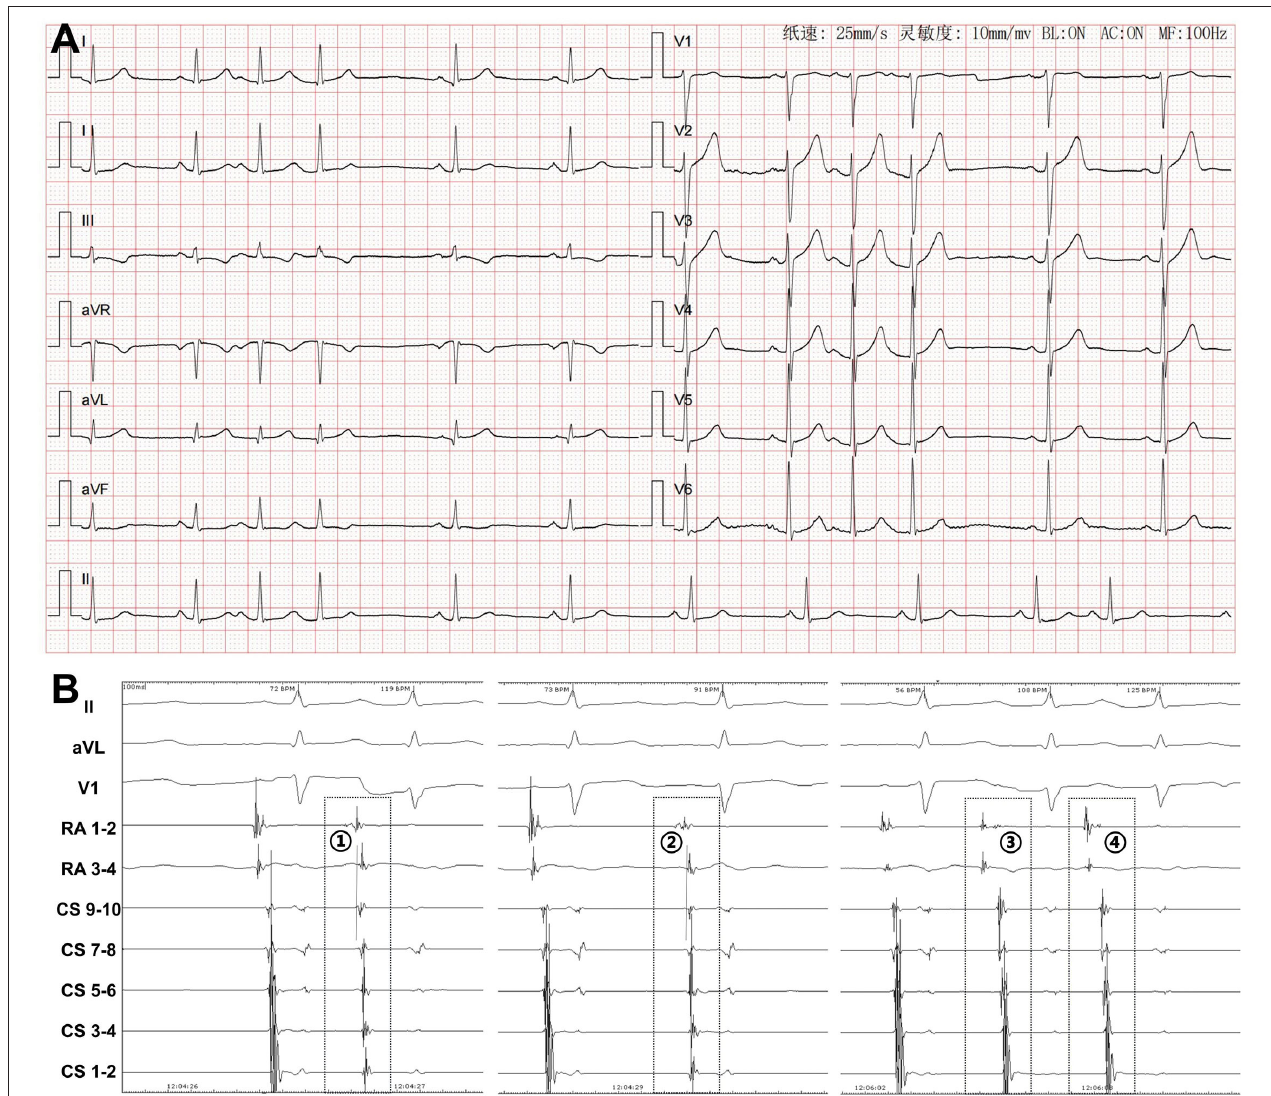
FIGURE 5 | Differentiation of spontaneous PACs and PACs induced by catheter manipulation during mapping procedure. (A) Twelve-lead surface ECG tracing during PACs. The P wave morphology is positive in precordial leads, inferior leads, and lead I, and negative in lead aVR and isoelectrical in lead aVL. (B) Simultaneous recording of surface ECG leads II, aVL, V 1 , RA 1 − 2 , RA 3 − 4 , and CS 9 − 10 ∼ CS 1 − 2 . During spontaneous PAC (PAC ‹ ), the distal RA activation is earlier than the proximal RA activation and the atrial activation sequence in CS is from proximal to distal. The atrial activation in CS 9 − 10 is earlier than that in RA 3 − 4 . During PAC induced by